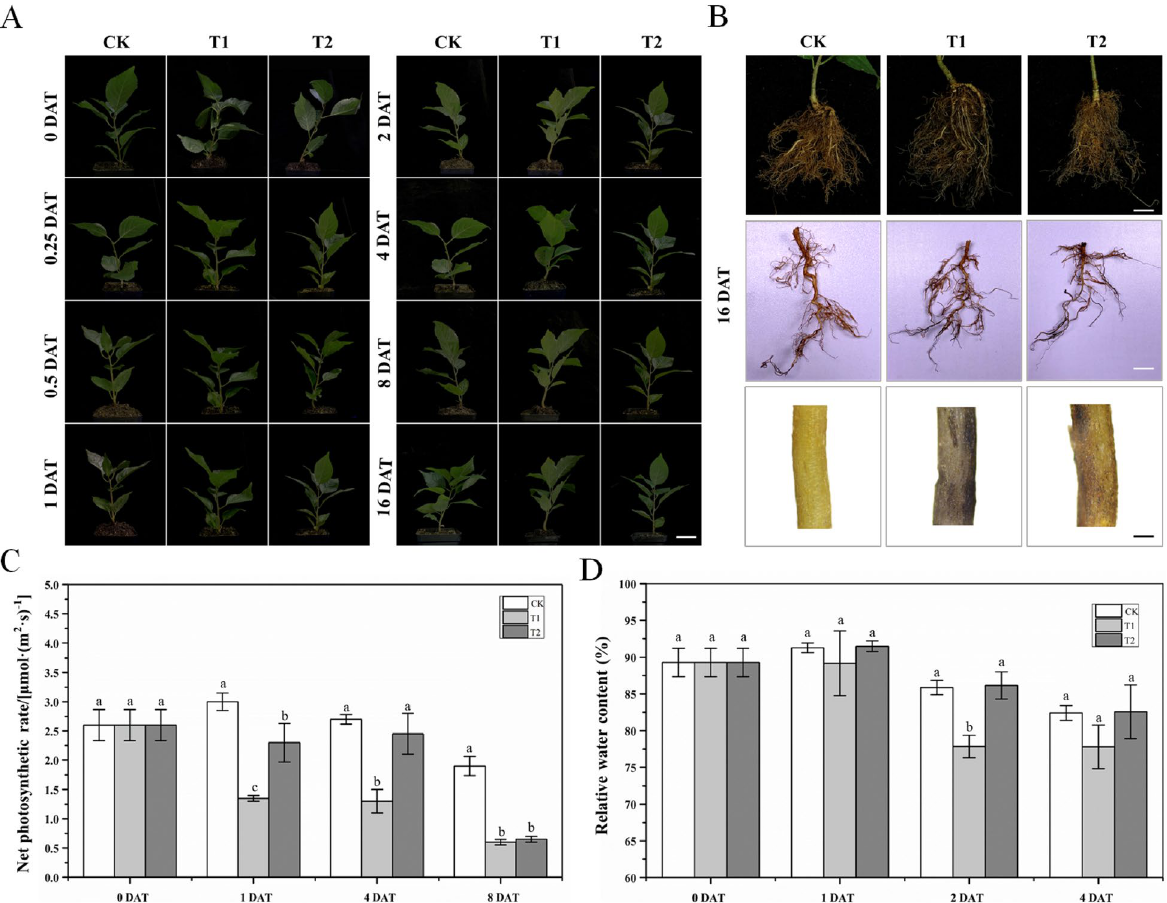
Fig. 4 Phenotypic traits of aboveground ( A ) and underground ( B ) parts, and changes in net photosynthetic rate ( C ) and relative water content (RWC) ( D ) in ‘Gisela 6’ (‘G6’) under waterlogging conditions, with or without oxygenation. The data are shown as mean replicates. Statistical significance was determined using one-way ANOVA; significant differences among means (least significant difference (LSD), p < 0.05) are indicated with different lowercase letters. Bars indicate 5 cm (Fig. 4A) and 3 cm, 1 cm and 1 mm (Fig. 4B),